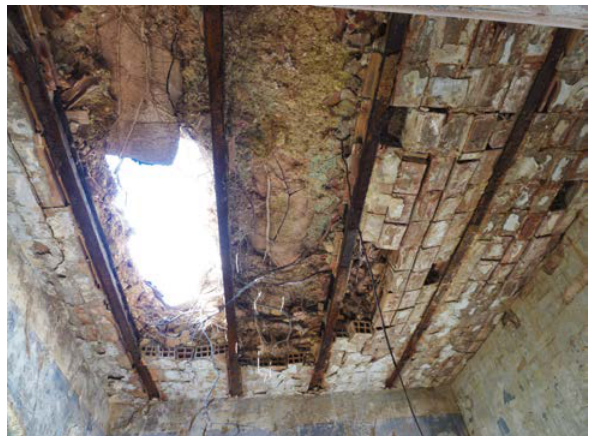
Figure 14. The types of